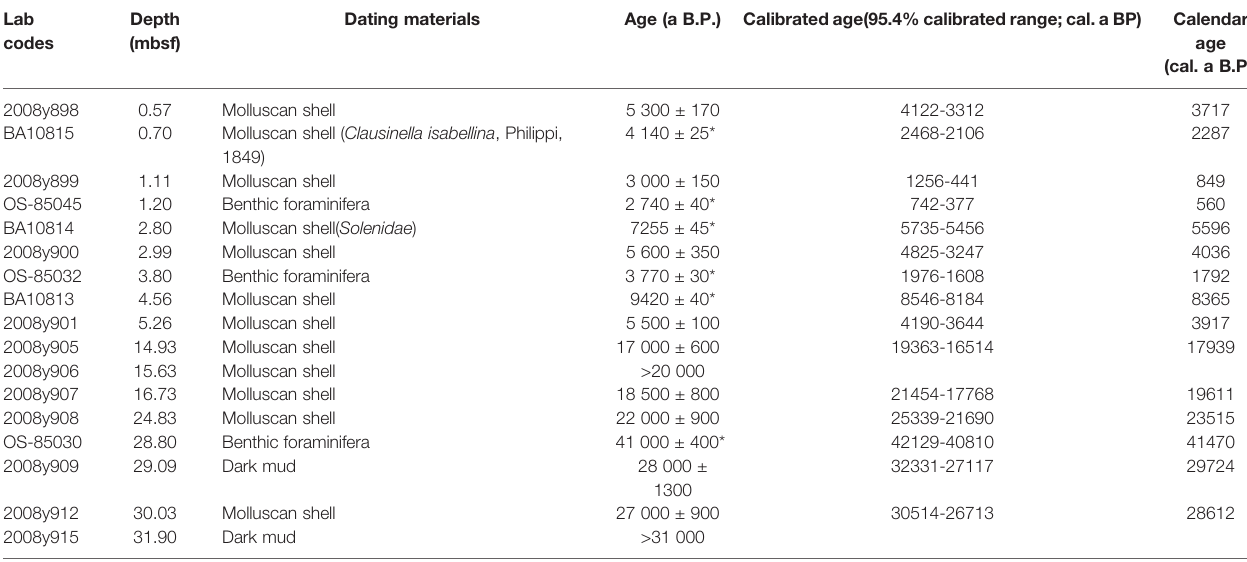
TABLE 1 | The radiocarbon ( 14 C) ages obtained by traditional and AMS methods on selected samples from borehole SFK-1 (calibrated ages). Lab